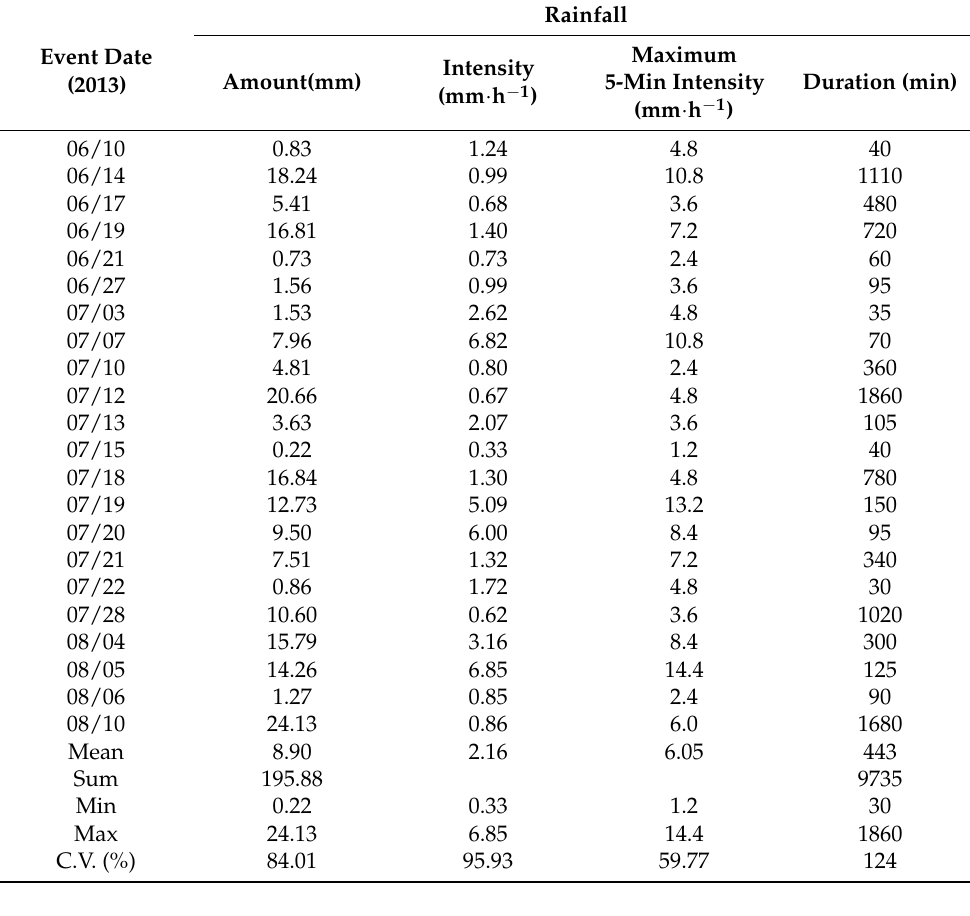
Table 2. Rainfall characteristics during full leaf stage.